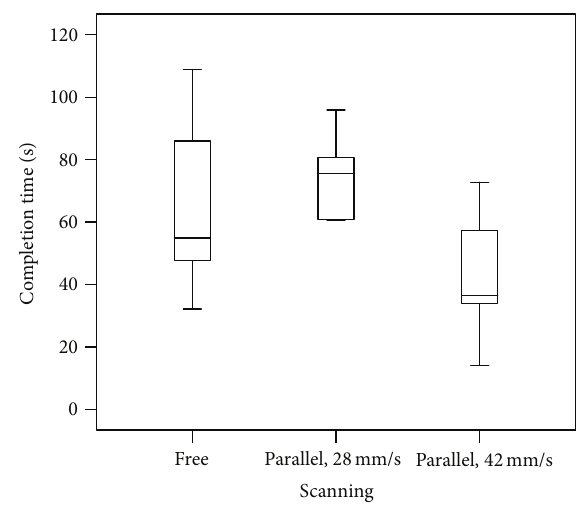
Figure 6: Typical results of one of the subjects: the task completion time in three conditions of exploration, recognition and identifica- tion of virtual shapes.